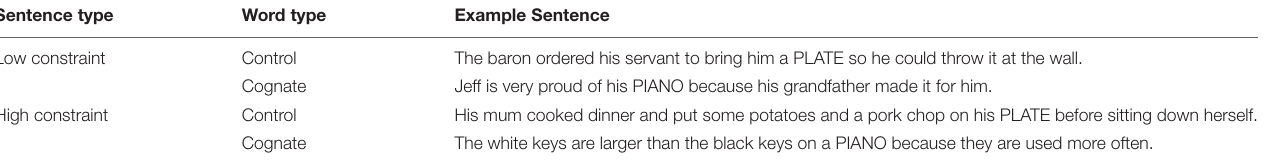
TABLE 1 | Examples of each condition that will be analyzed.